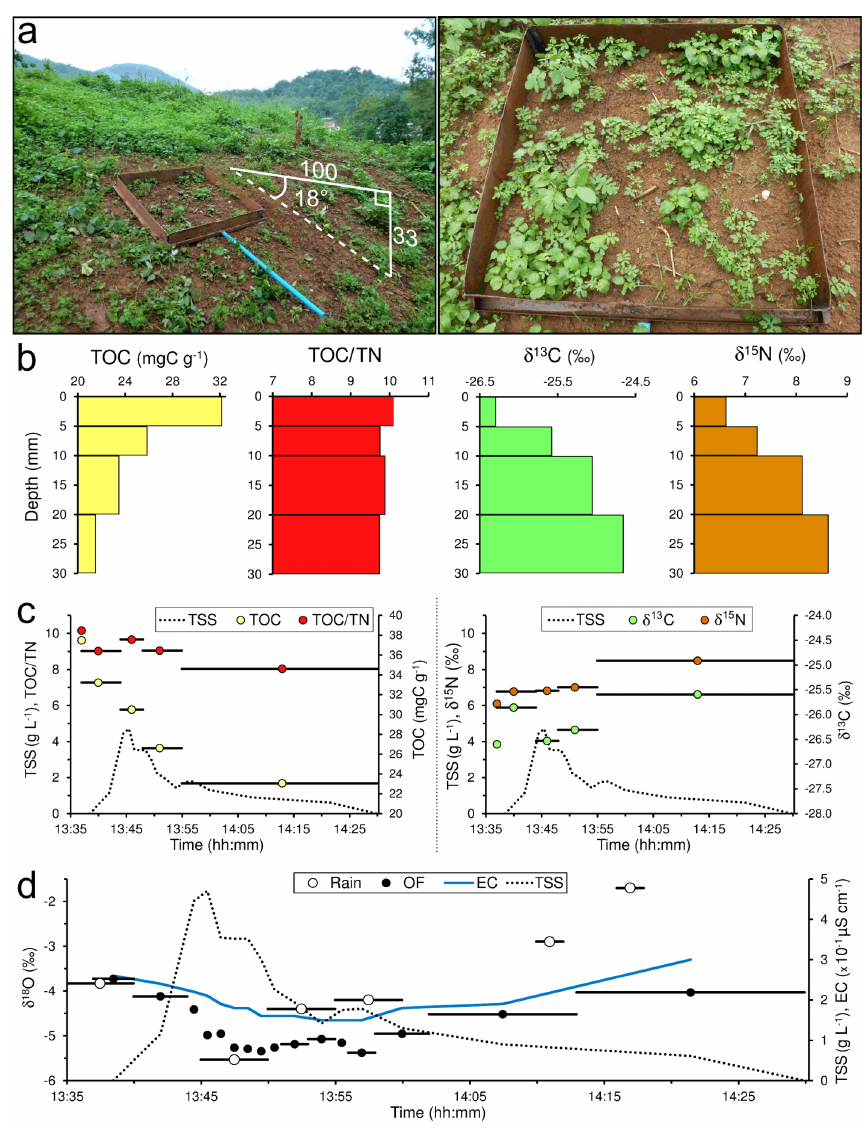
Figure 2. Microplot experiment: (a) the 1m 2 collecting system and its vegetation cover; (b) distribution of topsoil total organic carbon (TOC) concentration, total organic carbon:total nitrogen ratio (TOC / TN), δ 13 C and δ 15 N with soil depth; (c) temporal evolution of the total suspended sediment load (TSS) plotted with TOC and TOC / TN in TSS (left) and with δ 13 C and δ 15 N in TSS (right) during the 1 June storm and (d) temporal evolution of the overland flow TSS load with rainwater- δ 18 O (Rain), overland flow- δ 18 O (OF) and overland flow electric conductivity (EC) during the 1 June